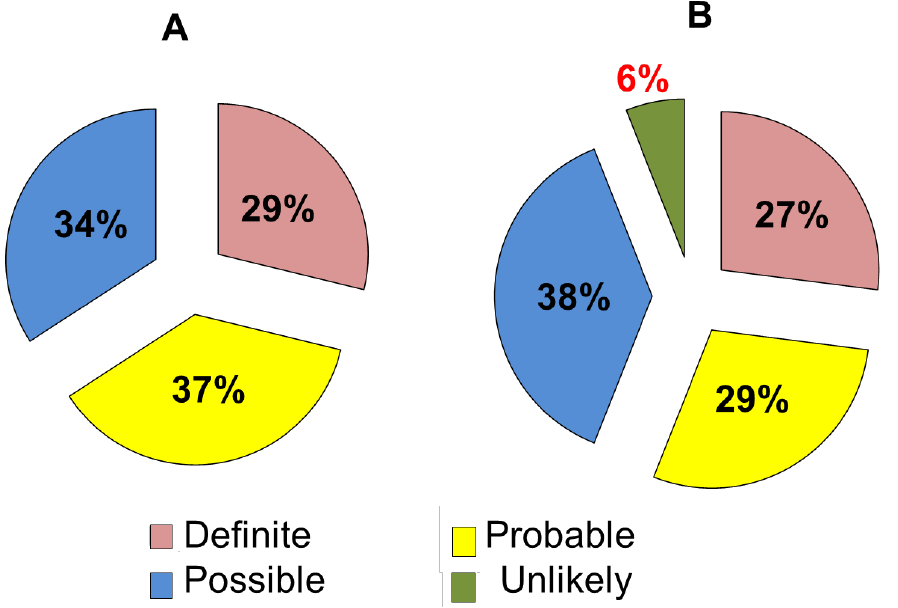
Figure 2. ( A ): Distribution of patients depending on the likelihood of familial hypercholesterolemia. ( B ): Distribution of patients depending on the probability of familial hypercholesterolemia after correction of low-density lipoprotein cholesterol level by lipoprotein(a). Note: Diagnosis of definite, probable, possible and unlikely familial hypercholesterolemia according to the Dutch Lipid Clinic Network criteria.